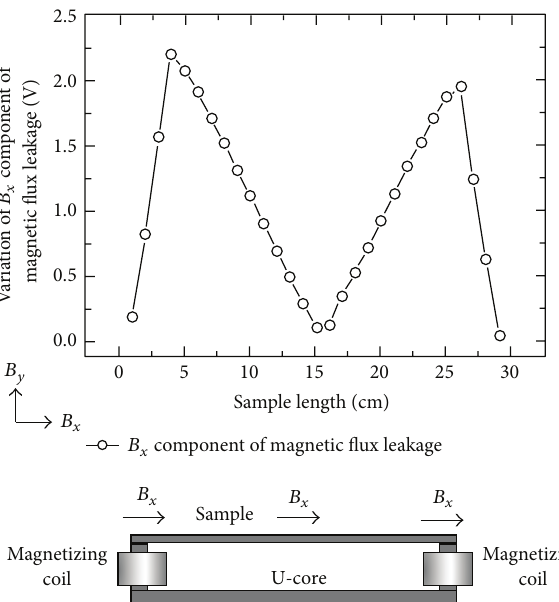
Figure 8: Measurement of 𝐵 𝑥 component of the magnetic flux leakage with sample between core legs without